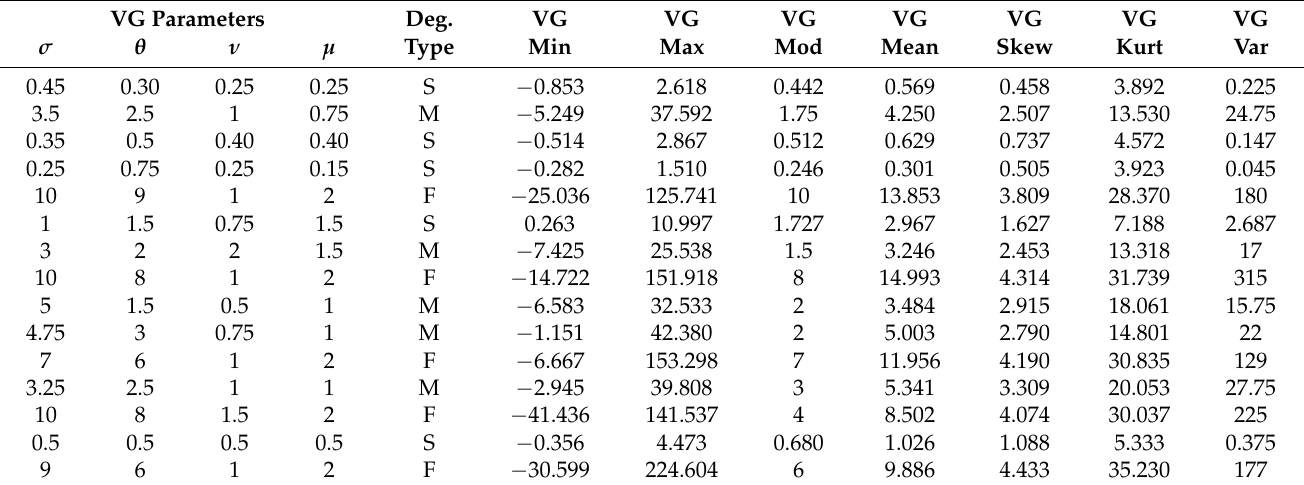
Table 2. Features of real data for 16 observations.